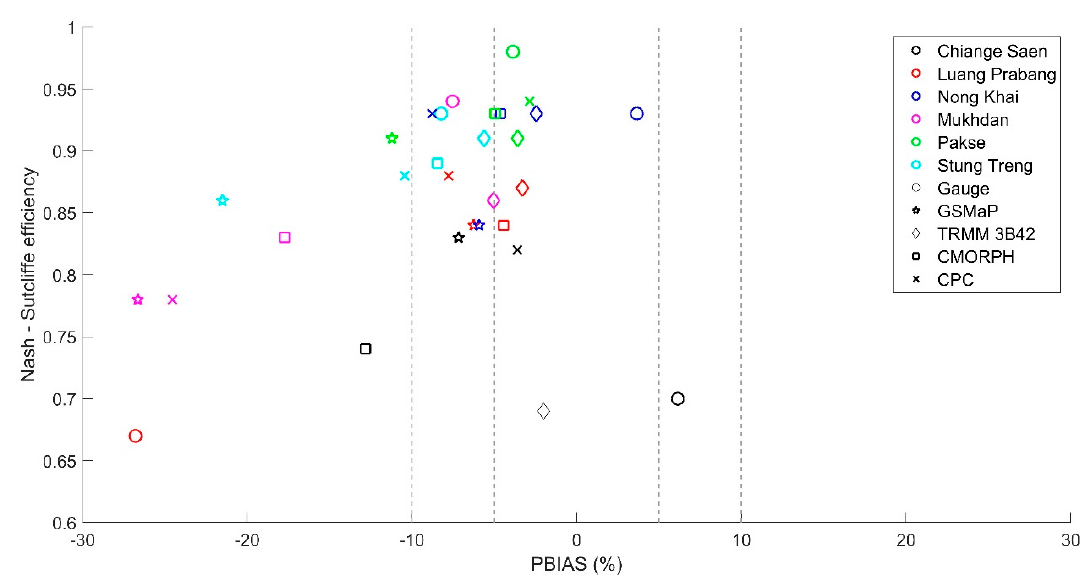
Figure 6. Nash–Sutcli ff e e ffi ciency coe ffi cient (NSE) and PBIAS of values of the hydrological stations. Table 5. Statistics index for the models of the Mekong River Basin using SWAT at six di ff erent stations. The P-factor and R-factor results for the calibration range from 0.68–0.98 and 0.67–1.55, respectively, which reveals that all of the simulations to capture streamflow discharge acquire